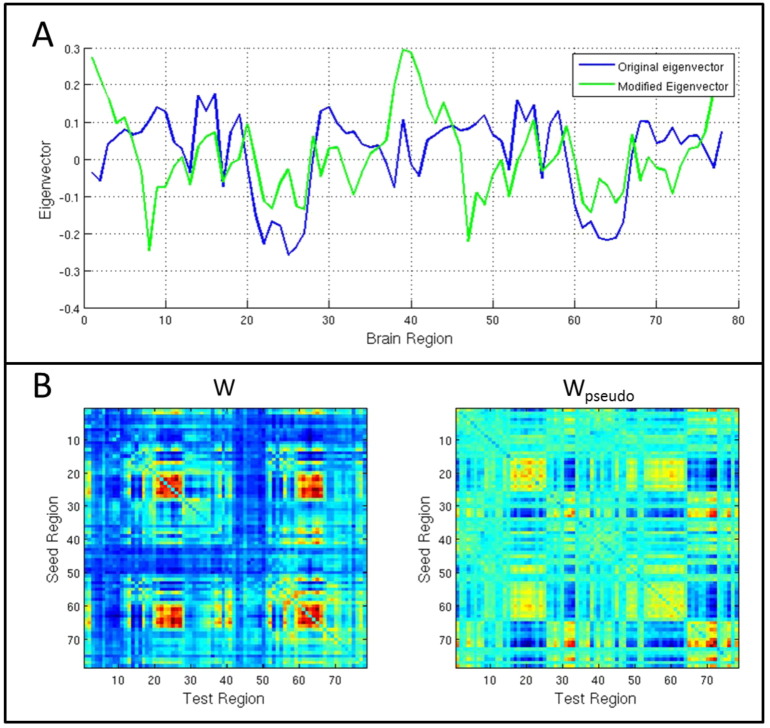
Example construction of a pseudo-matrix. A) The blue trace shows the second eigenvector of a genuine MEG alpha band AEC adjacency matrix. The green trace shows the phase randomised version. Note that the periodicity (which reflects spatial symmetry in the ordering of brain regions across the two hemispheres in the AAL parcellation) has been maintained. B) The left hand panel shows the genuine MEG adjacency matrix. The right hand panel shows a single example of a phase randomised pseudo-matrix. Note overall visual similarity in structure and smoothness.